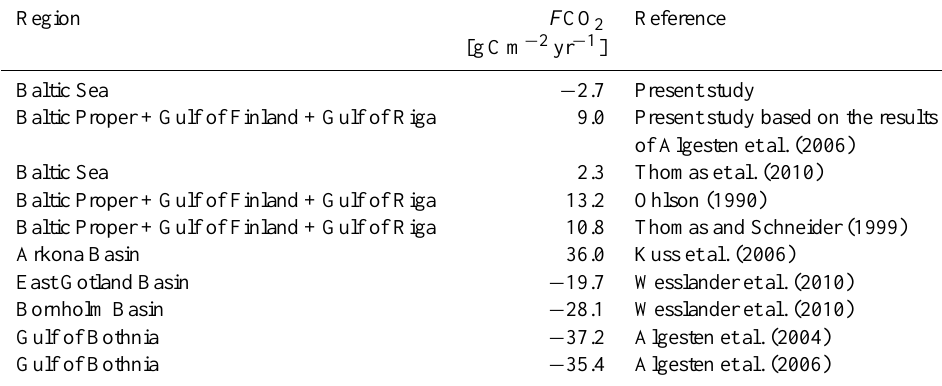
Table 3. Comparison of the F CO 2 results obtained with the literature data reported for the Baltic Sea. Positive values of F CO 2 indicate CO 2 sequestration in seawater, whereas negative ones indicate emission of CO 2 to the atmosphere. The Baltic Sea basins presented in the table are shown on Fig.